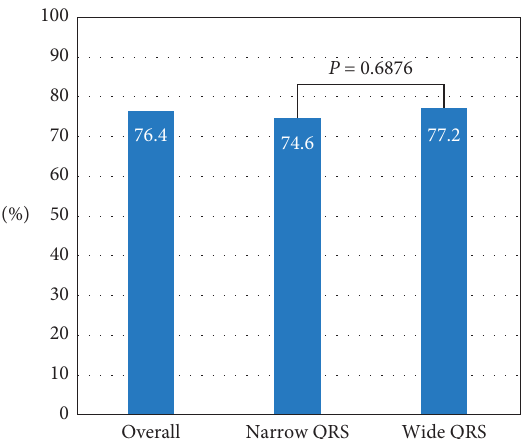
Figure 1: CRT response rate, overall, narrow, and wide QRS